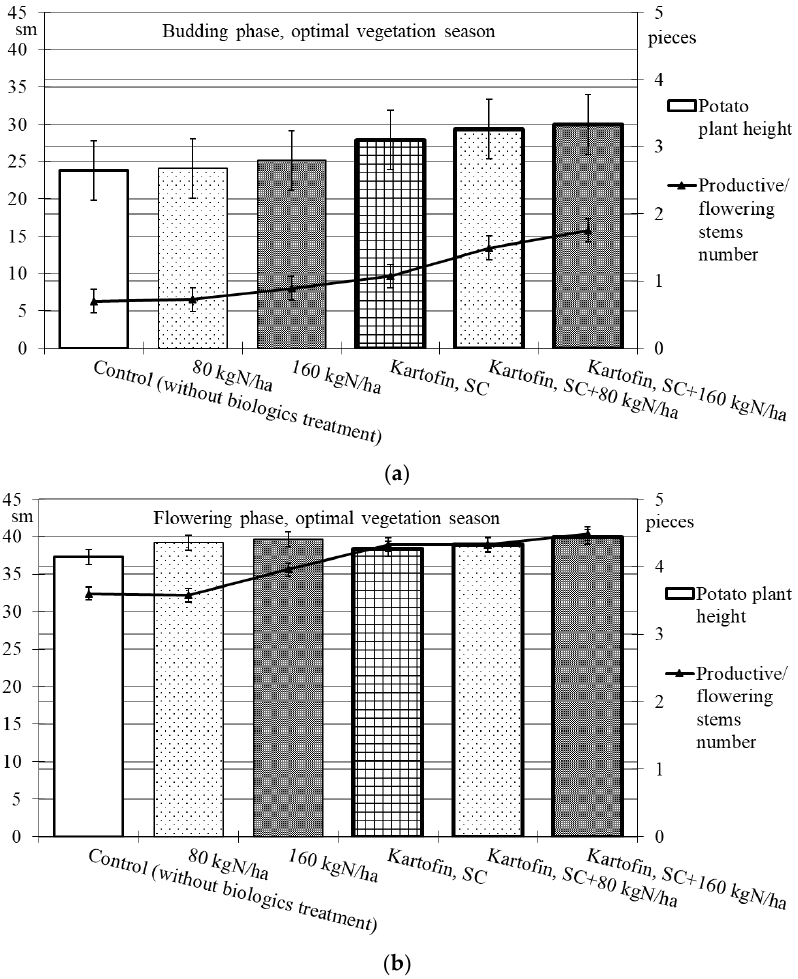
Figure 2. Effect of application polyfunctional biologicals (Kartofin, SC; Kartofin MR, SC) and organic fertilizer BIAGUM in doses of 80 and 160 kg N ha − 1 on biometric indicators (plant height—sm; productive stems number—pieces) of the potato plants development in organic growing during optimal vegetative season: ( a )—in budding phase; ( b )—in flowering